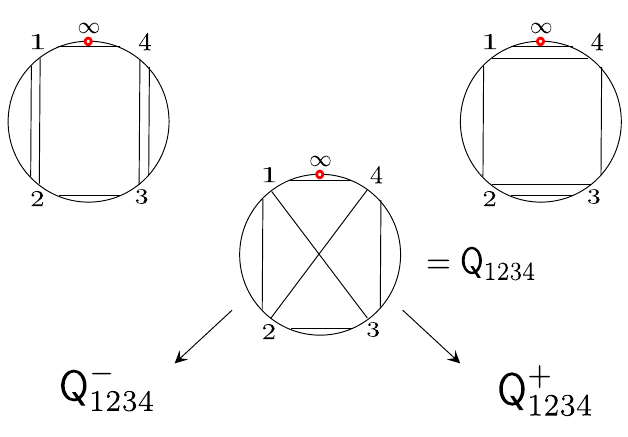
Figure 12 . The decomposition of the scalar quartic diagram. The scalar quartic diagram sits \in the middle" of two di(cid:11)erent tree-level graphs. By decomposing the scalar quartic diagram into two pieces (3.11), one can associate each contribution with a tree-level